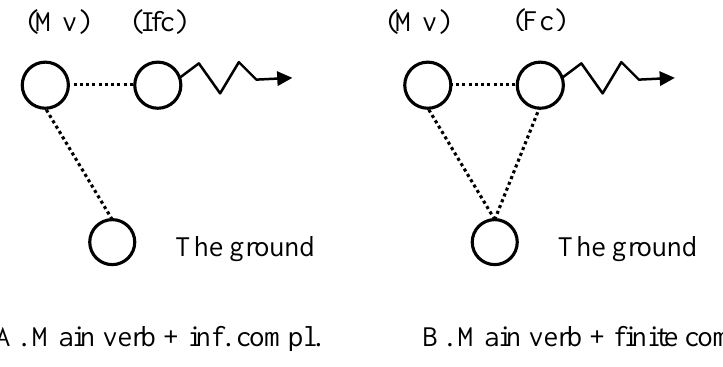
Figure 5. The relation between the ground and the linguistic